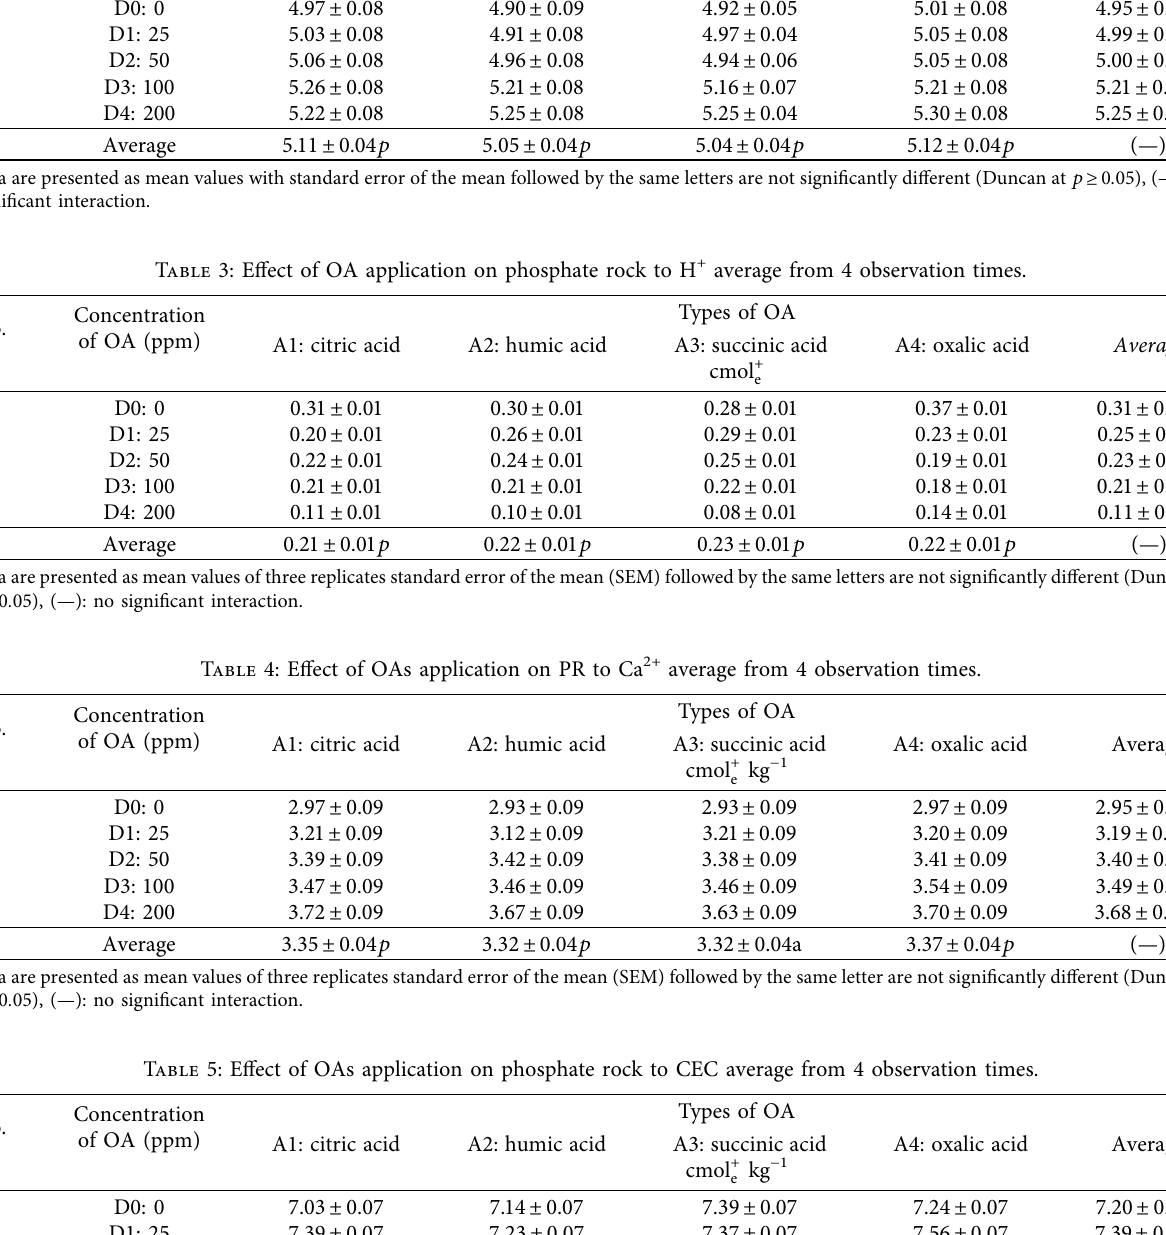
Table 2: Efect of organic OA application on phosphate rock to pH H